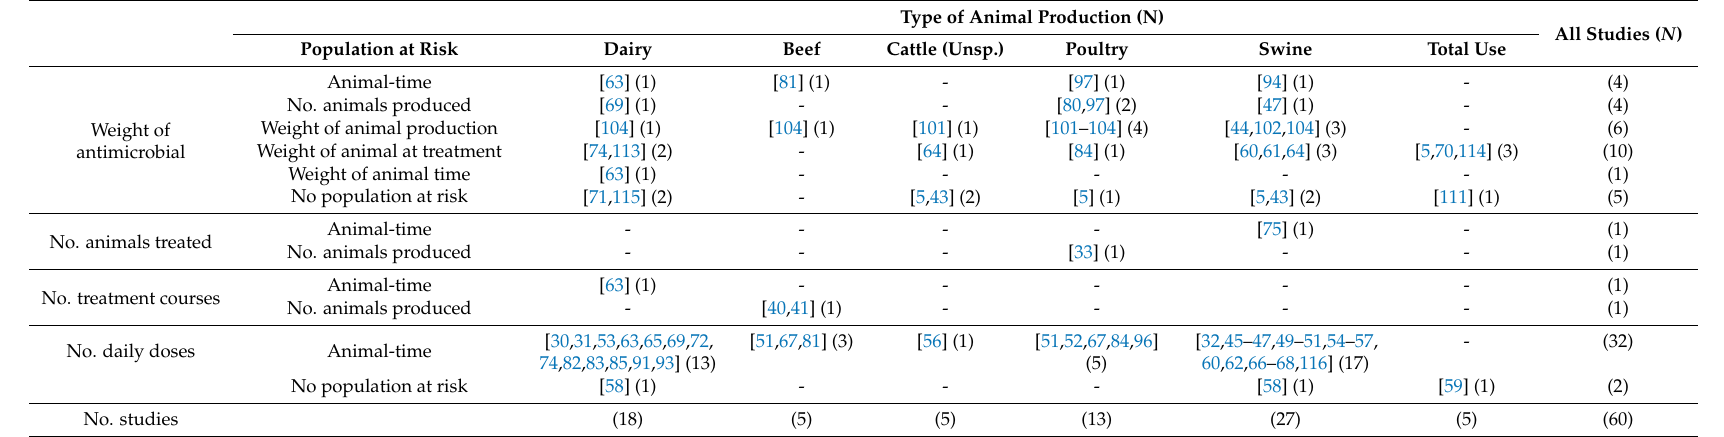
Table 2. Classification of 60 publications reporting antimicrobial use (AMU) quantitative data by the type of metrics used and animal production types. Studies performed in LMICs are underlined. The number of publications reporting using those metrics is given in